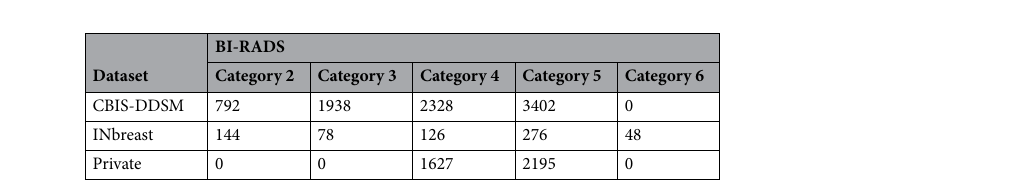
Table 4. BI-RADS category class labels